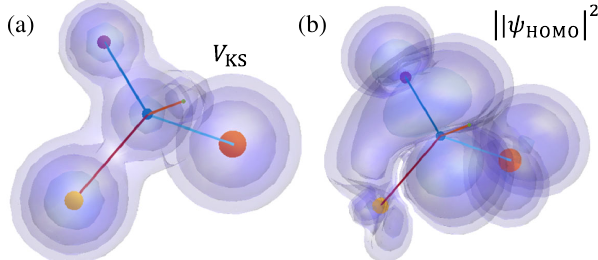
FIG. 7. (a) Effective KS potential for the molecular CBrClFH ion. (b) The HOMO orbital for the effective KS potential used in calculations. Blue, purple, yellow, red, and green spheres stand for C, F, Cl, Br, and H atoms, respectively. Isosurfaces for the potential 2 are s ¼ 0 . 05 ; 0 . 1 ; 0 . 25 ; 0 . 75 j ψ j max